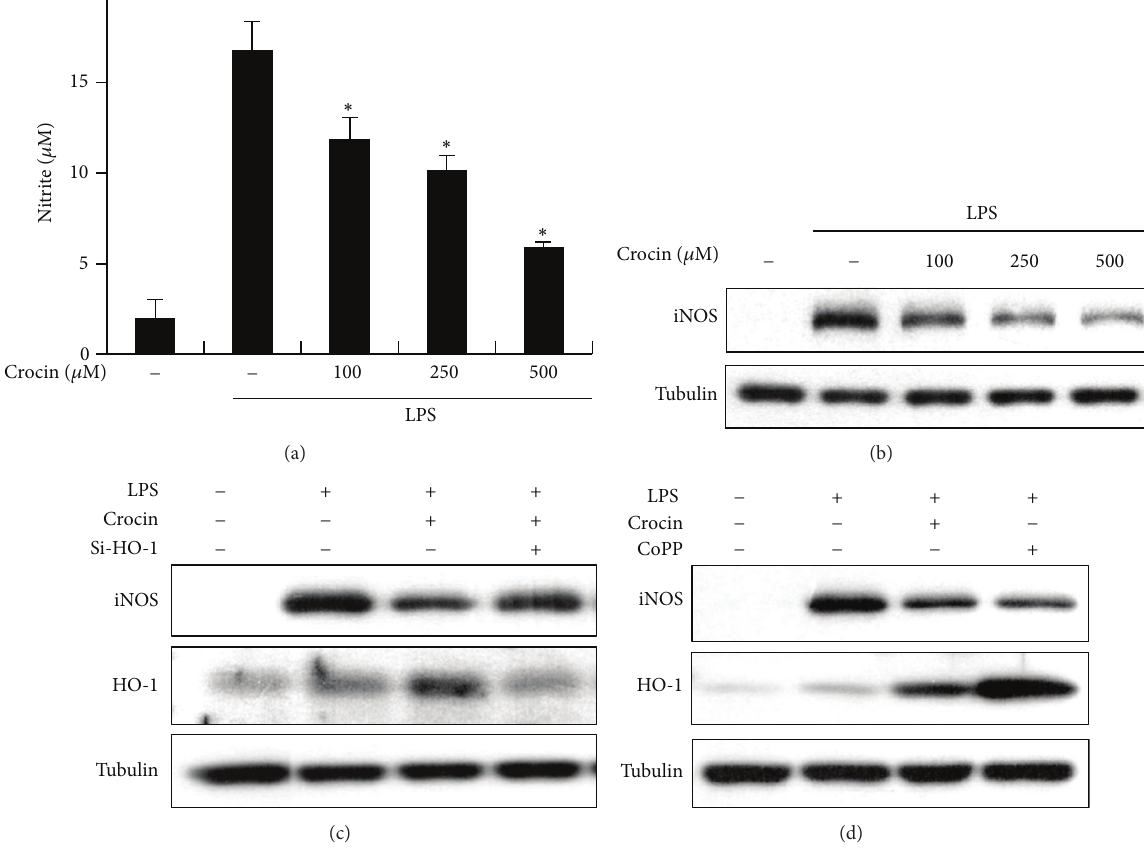
Figure 2: Inhibitory effects of crocin on NO production and iNOS expression in LPS-stimulated macrophages. ((a), (b)) RAW 264.7 cells were incubated with the indicated concentrations of crocin for 3 h and then stimulated with LPS (0.1 𝜇 g/mL) for 24 h. Next, the supernatant was harvested and the amount of nitrite released from cells was measured by the Griess method (a). ∗ 𝑃 < 0.05 versus the group treated with LPS alone (no crocin). Equal amounts of cytosolic extract were analyzed by Western blotting (b). (c) Cells were transfected with HO-1 siRNA or control siRNA. Cells were treated with crocin (500 𝜇 M) for 3 h and then were stimulated with LPS (0.1 𝜇 g/mL) for 6h. (d) Cells were incubated with crocin (500 𝜇 M) or CoPP (10 𝜇 M) for 3h and then stimulated with LPS (0.1 𝜇 g/mL) for 24 h, after which protein levels of iNOS and HO-1 were analyzed by Western blotting. Tubulin was used as a loading